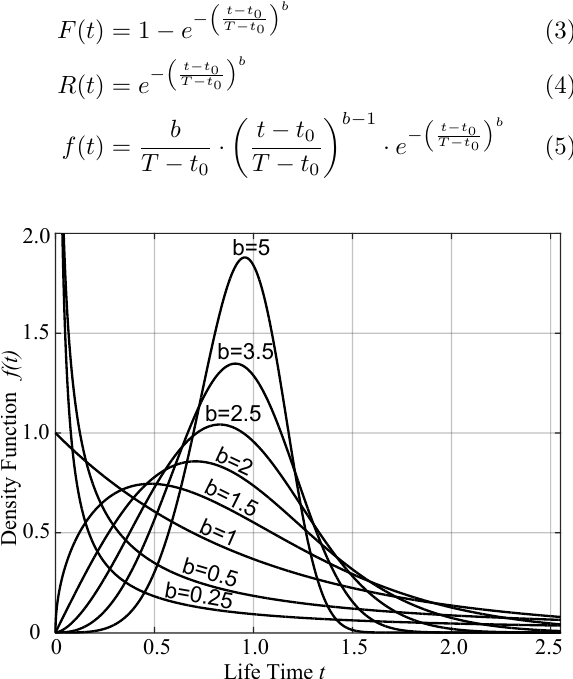
Figure 5: Weibull density functions for different shape parameters b Bertsche and Lechner